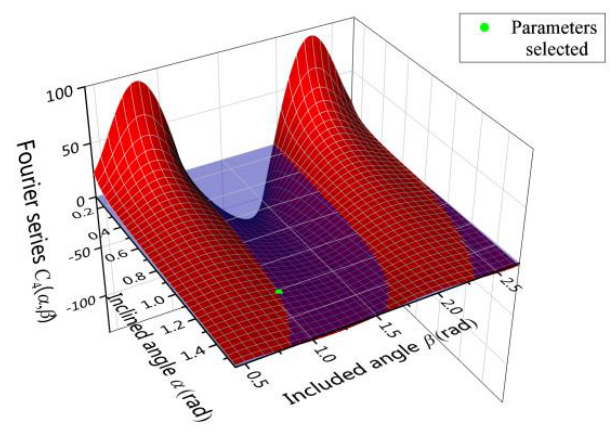
Figure 9. Variation of the C 4 ( α , β ) with inclined angle α and included angle β .